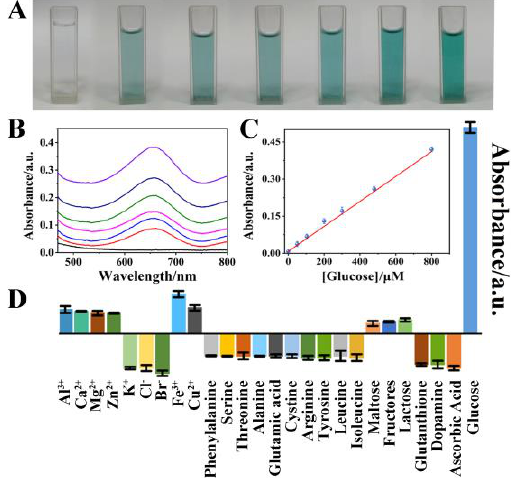
Figure 4. ( A ) A picture of the reaction mixture with various concentrations of glucose present. ( B )